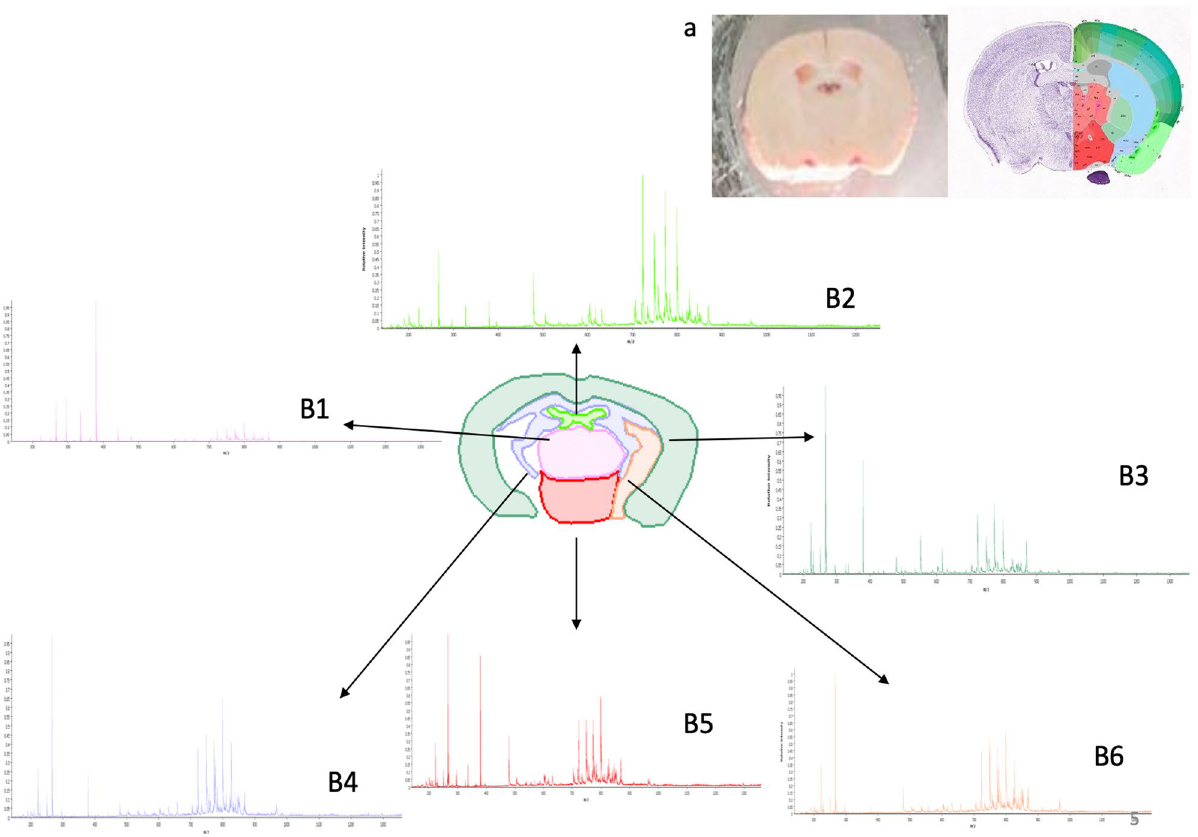
Figure 5. (a) Cortical brain section at 5.9 mm depth from Allen Brain. (b) Edges of the cortex, the striatum and the hypothalamus, thalamus, amygdale and ventricles drawn with Scills and FlexImaging 4.1 software (Bruker Daltonics Inc.). B 1–6 mean spectra of brain regions in negative mode in the range mass of m/z 200–1400, normalized with the TIC. (b1) Thalamus, (b2) ventricles, (b3) cortex, (b4) amygdale, (b5) hypothalamus and (b6)